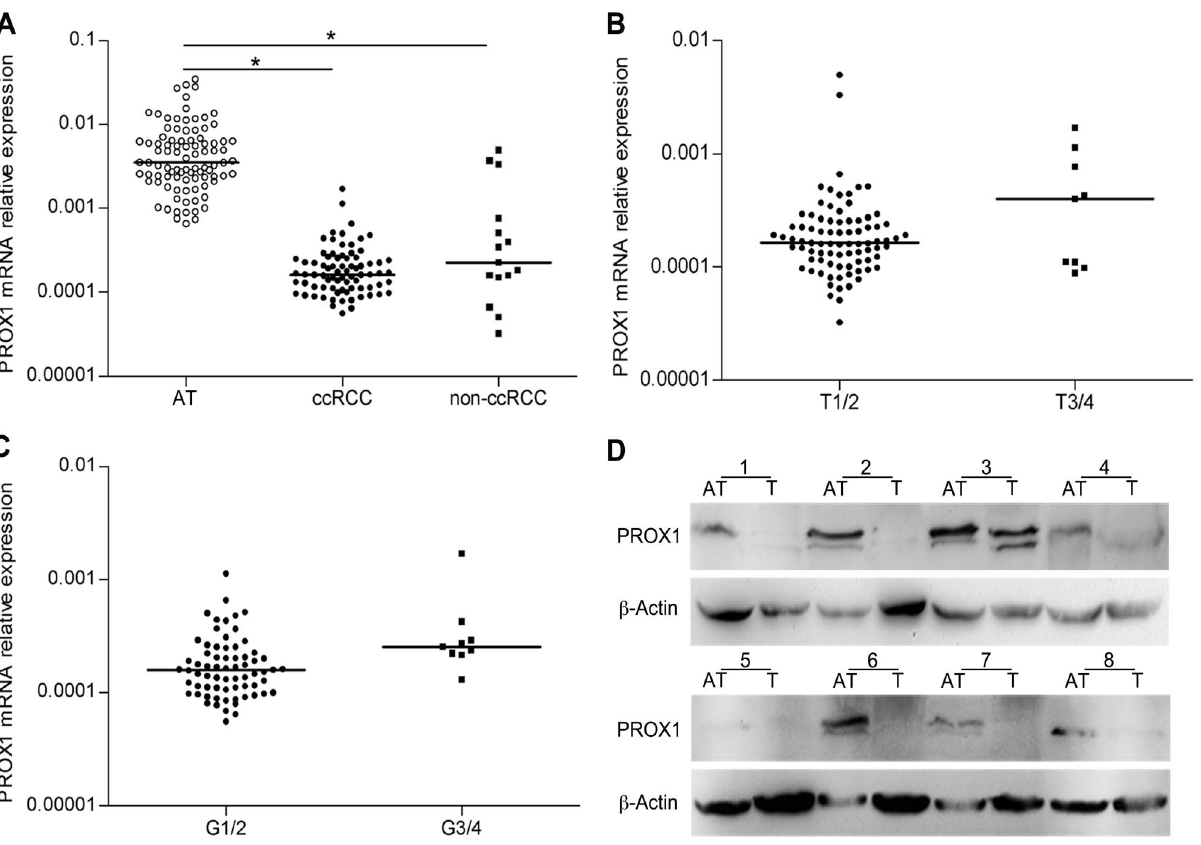
Figure 1. Real-time qPCR and Western blot analyses of PROX1 expression in RCC and corresponding adjacent tissues. The relative expression of PROX1 mRNA was significantly lower in both ccRCC and non-ccRCC tissue than in adjacent normal tissue (a). PROX1 mRNA trended higher (though not significantly) in T3/4 and G3/4 RCC specimens compared with T1/2 and G1/2 specimens, respectively. (b and c). PROX1 protein expression levels were clearly reduced in 6 of 8 RCC specimens compared with adjacent normal tissue (d). Bars, median relative expression levels. * P , 0.001.